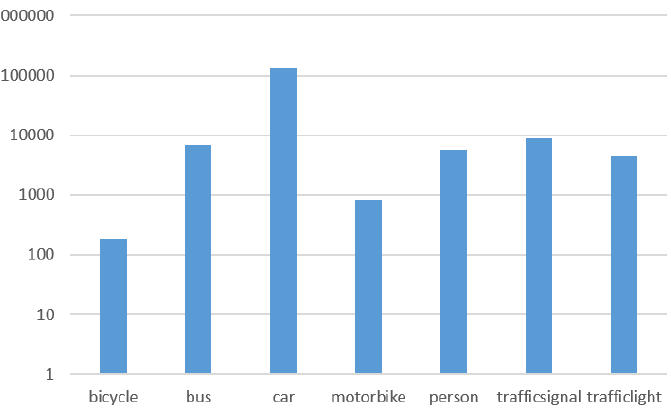
Figure 4. Number of annotations per class from the first set of automatic annotated images. There were 157,406 annotated objects captured with an HD sport camera with a 1280 × 720